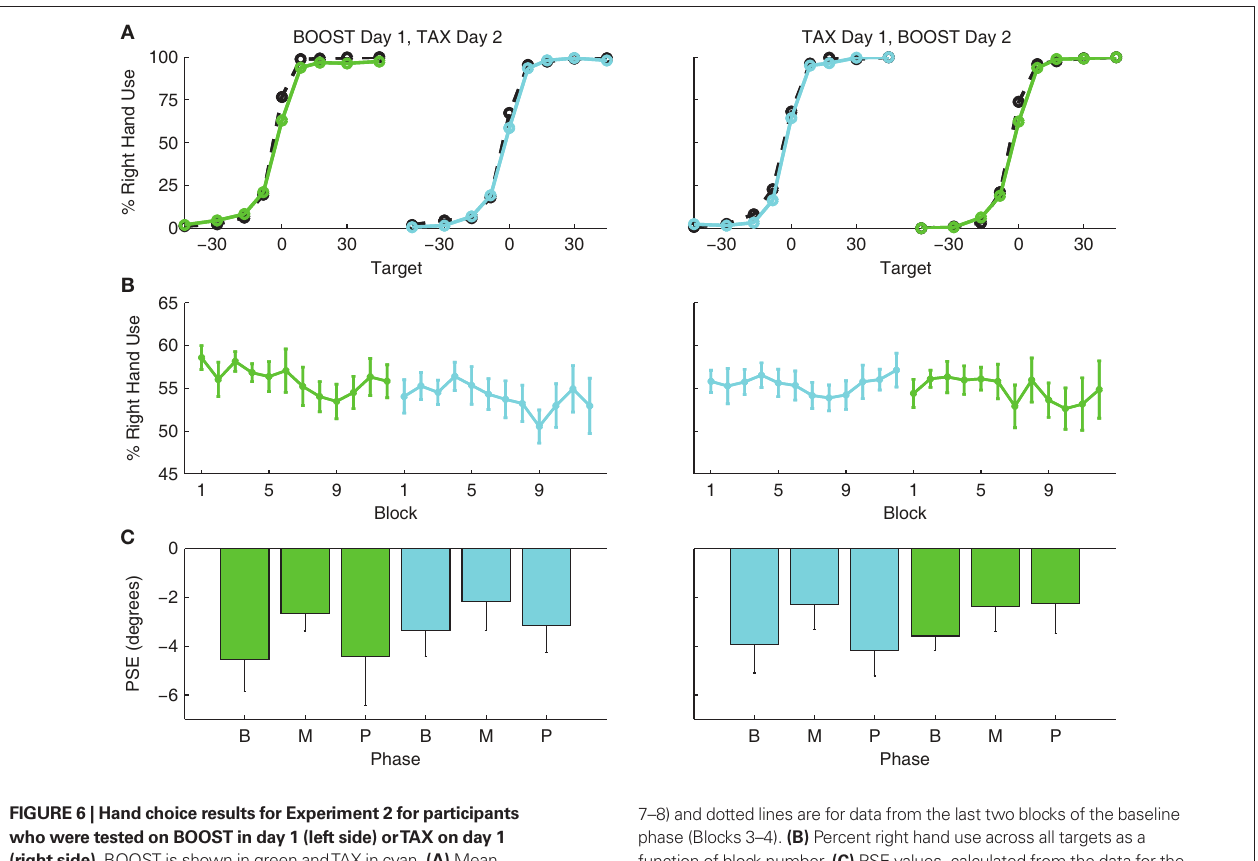
7–8) and dotted lines are for data from the last two blocks of the baseline phase (Blocks 3–4). (B) Percent right hand use across all targets as a function of block number. (C) PSE values, calculated from the data for the last two blocks of each phase (B, baseline; M, manipulation; P,